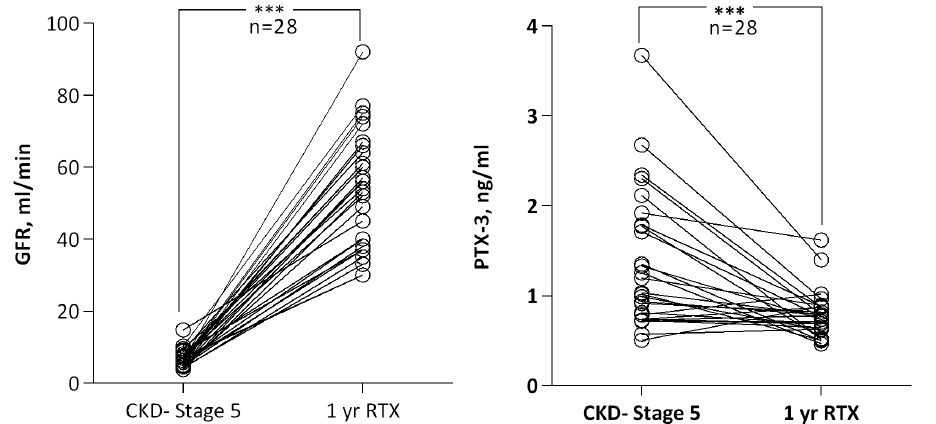
Figure 2. Plasma levels of PTX3 are decreased after kidney transplantation (RTx). One year after transplantation glomerular filtration rate (GFR) is improved and plasma PTX3 concentrations are significantly decreased compared to baseline (N=28, Wilcoxon signed rank test). ***, p , 0.001.